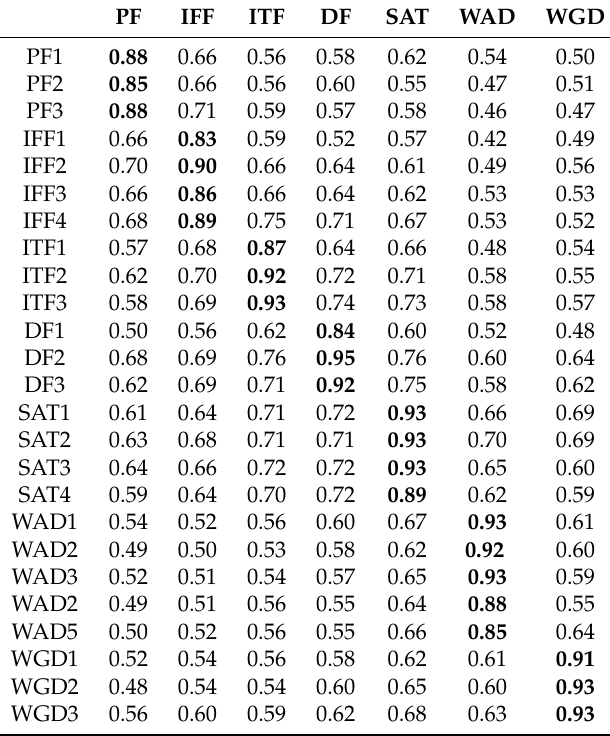
Table 2. Confirmatory factor analysis.